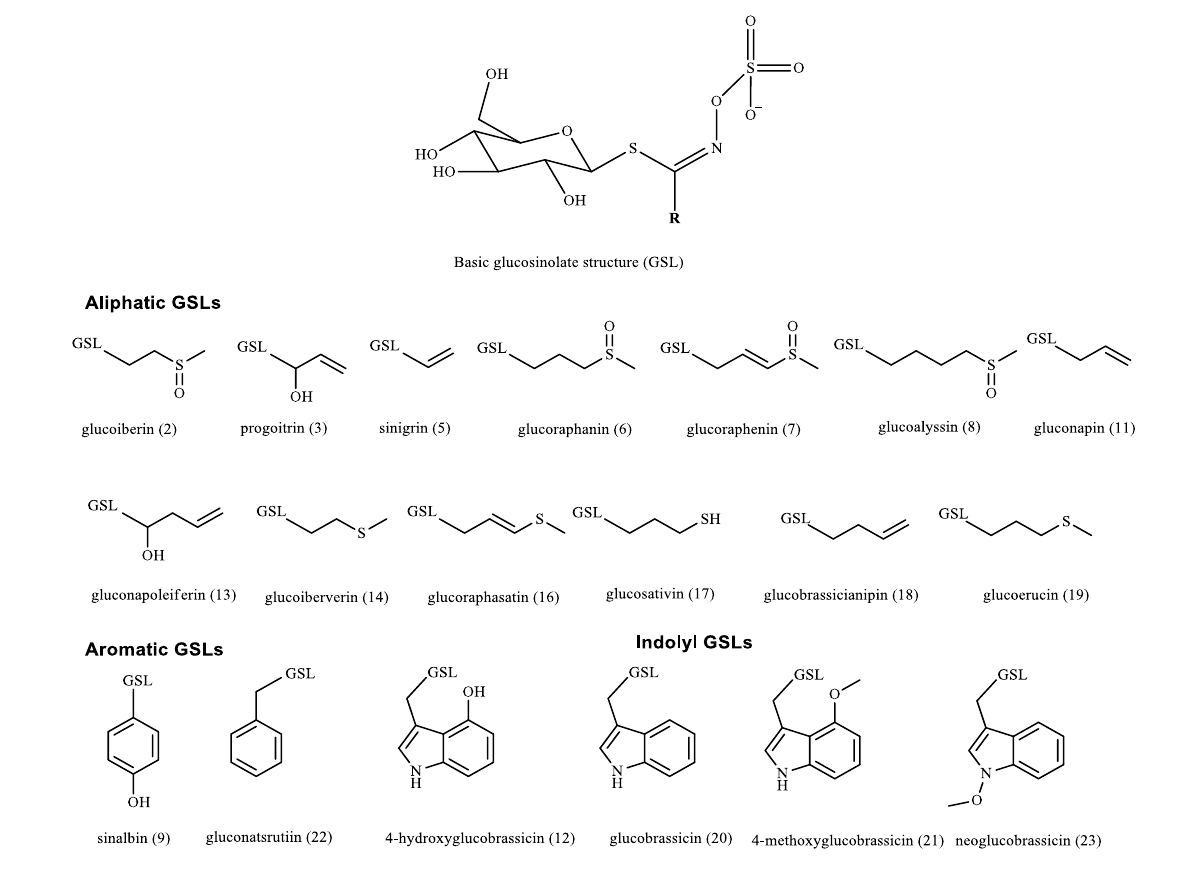
Figure 1. Glucosinolates detected in the alcoholic extracts of the studied Brassicaceae seeds by HPLC – PDA.